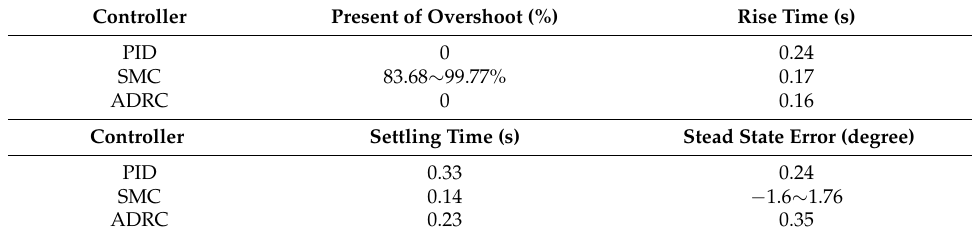
Table 3. The performance of the PID, the SMC and the ADRC controller.